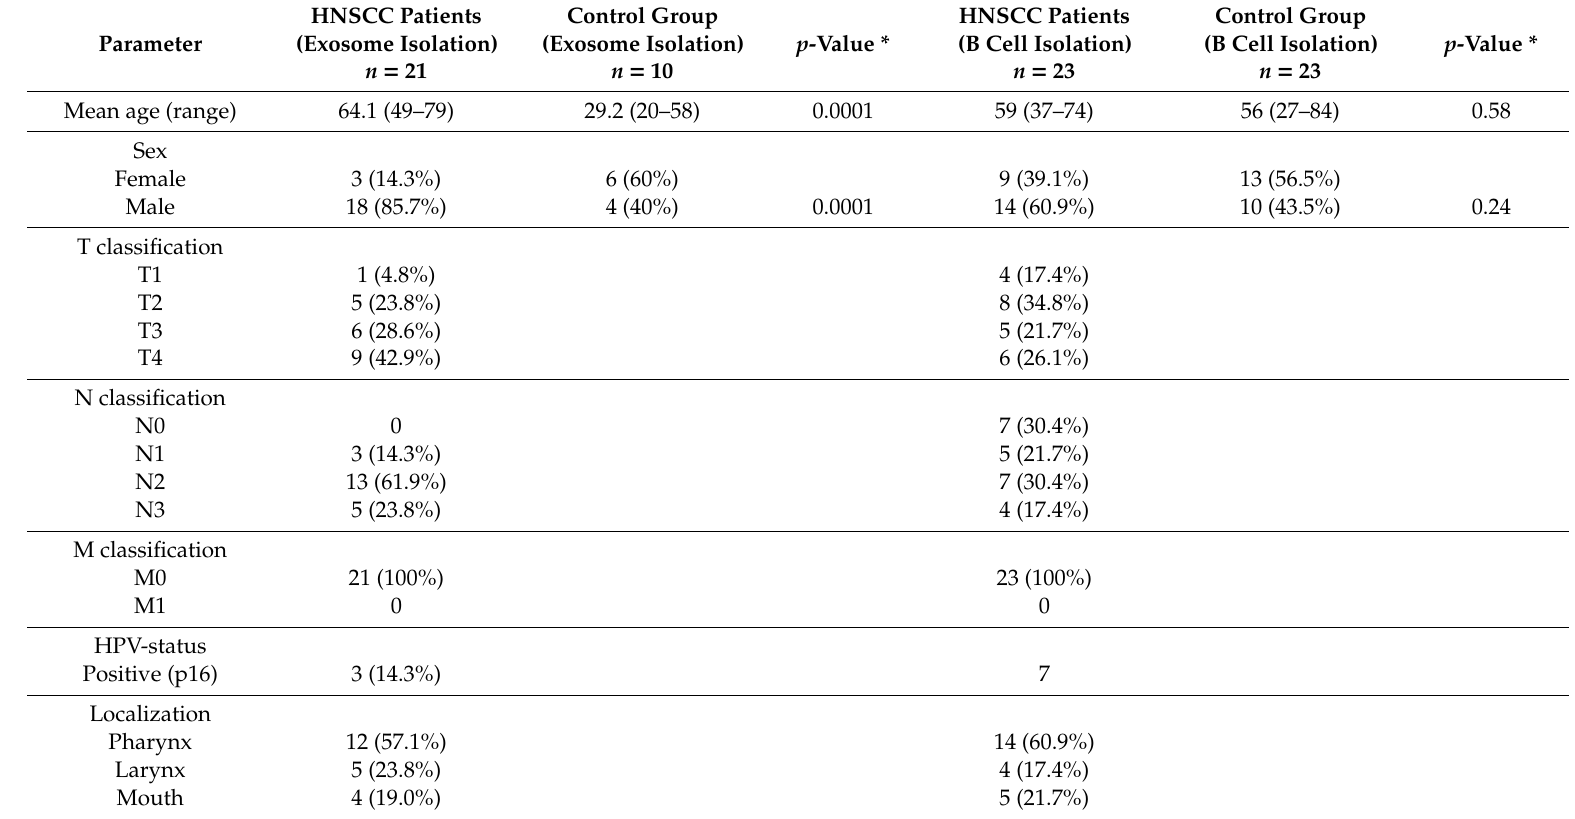
Table 1. Clinicopathological parameters for patients with head and neck squamous cell